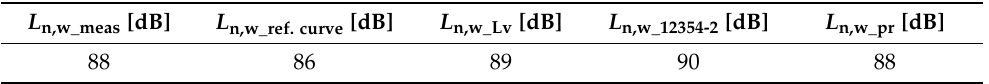
Table 4. Weighted normalized impact sound pressure level, L n,w .